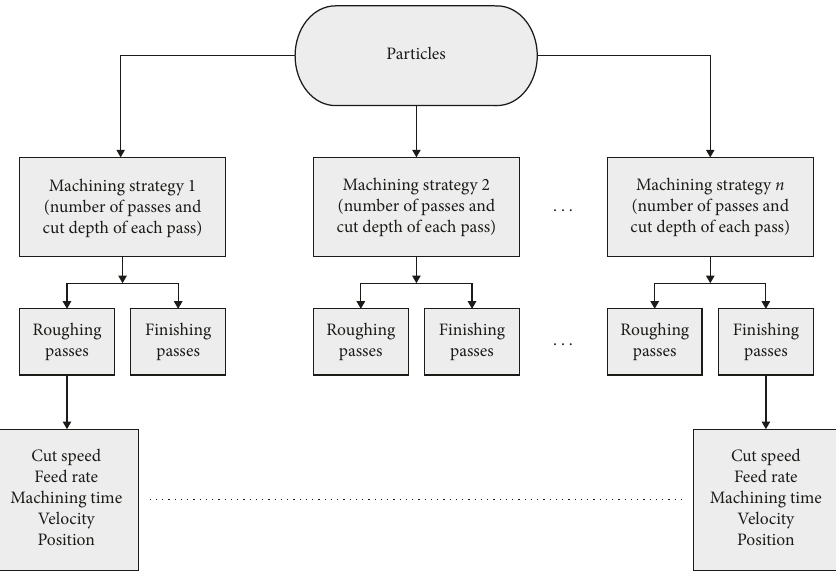
Figure 1: The representation of a solution to the milling parameters optimization problem.